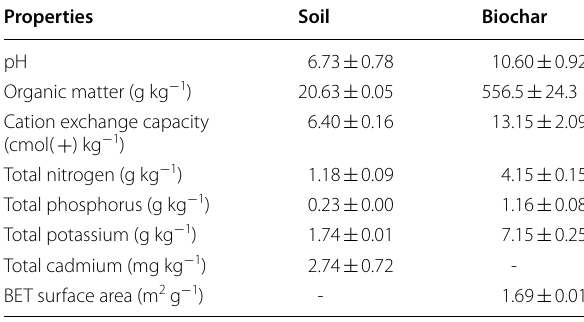
“-”: not determined. Data are mean